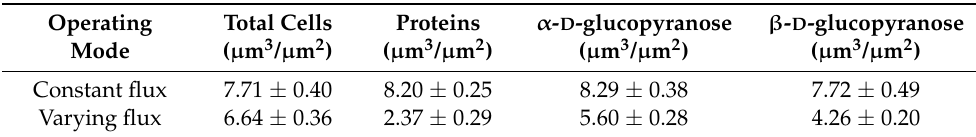
Figure 4. Images of the fouled MF membranes obtained from confocal laser scanning microscope (CLSM) at different operating modes of constant flux ( a ) and varying flux ( b ).